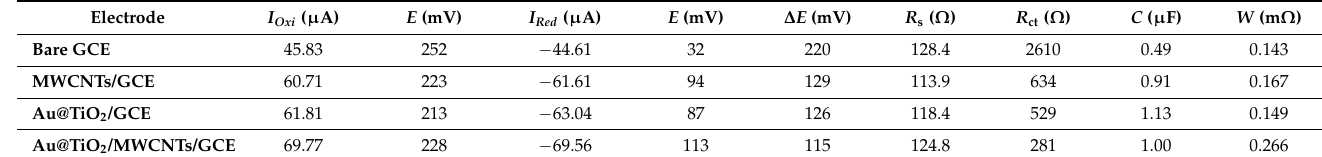
Table 1. CV and EIS performance data for modified and bare electrodes in [Fe(CN) 6 ] 3−/4− .